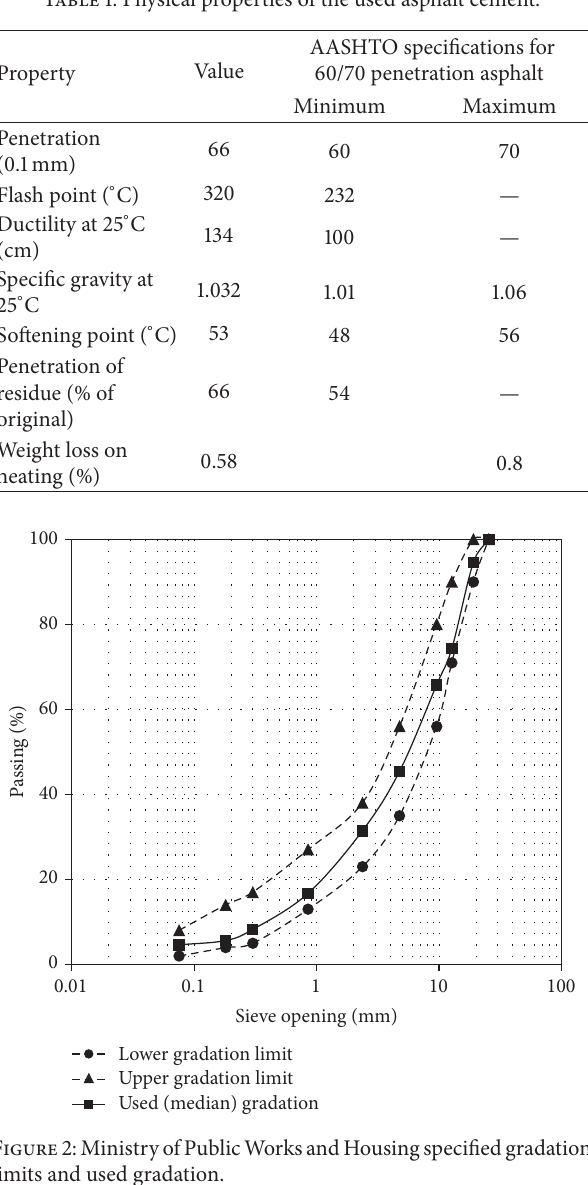
Table 2: Physical analysis of the used wire